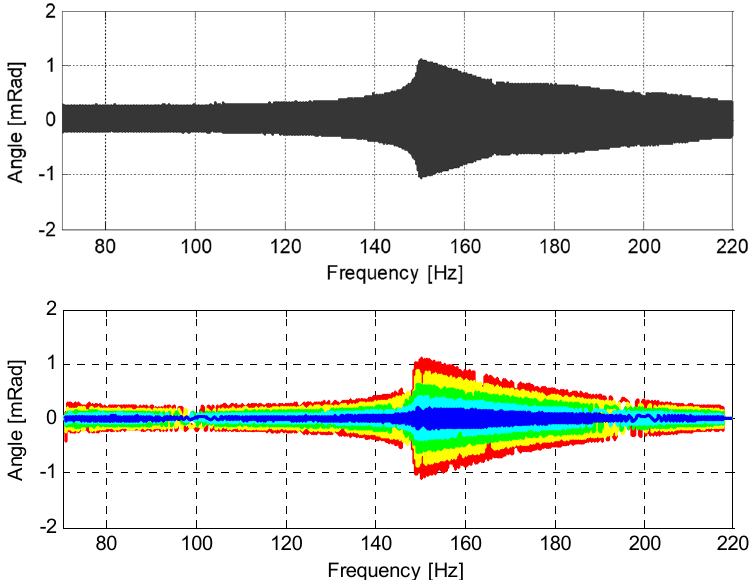
Figure 18. The results of RC testing. Standard RC test results are at the top; the results from the additional accelerometers are at the bottom. Material: Sand 3 (Sa); Isotropic pressure 100 kPa; Frequency spectrum 70–220 Hz; Excitation (torque) amplitude 4 V (– original built-in sensor, – the top sensor, S1, – the second sensor from the top, S2, – the third sensor from the top, S3, – the fourth sensor from the top, S4, – the bottom sensor, S5).